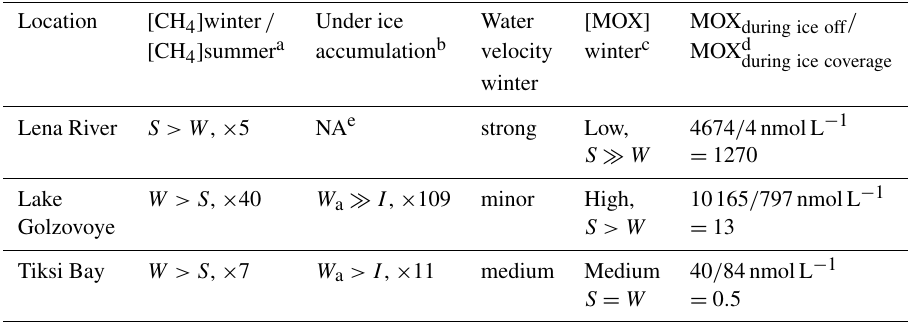
Table 2. Comparison of methane concentration in water and ice as well as methane oxidation rates (MOX) at different sites and in different seasons. Location [ CH 4 ] winter / Under ice Water [ MOX ] MOX during ice off / [ CH ] summer a accumulation b velocity winter c MOX d 4 during ice coverage winter Lena River S > W , × 5 NA e strong Low, 4674 / 4nmolL − 1 S (cid:29) W = 1270 Lake W > S , × 40 W a (cid:29) I , × 109 minor High, 10165 / 797nmolL − 1 Golzovoye S > W = 13 Tiksi Bay W > S , × 7 W a > I , × 11 medium Medium 40 / 84nmolL − 1 S = W = 0 .